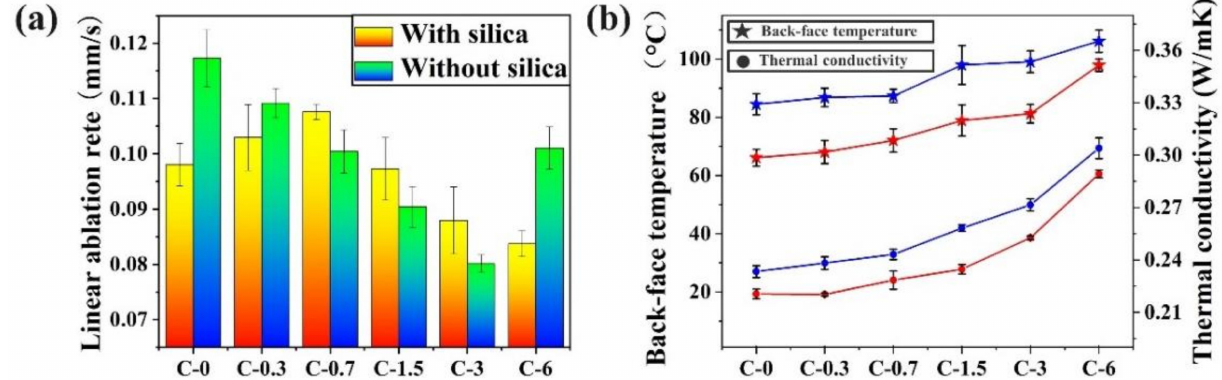
Figure 1. Effects of MWCNTs content on linear ablation rate ( a ) and thermal insulation performance ( b ) of the EPDM-based insulators with (Blue line) and without silica (Red